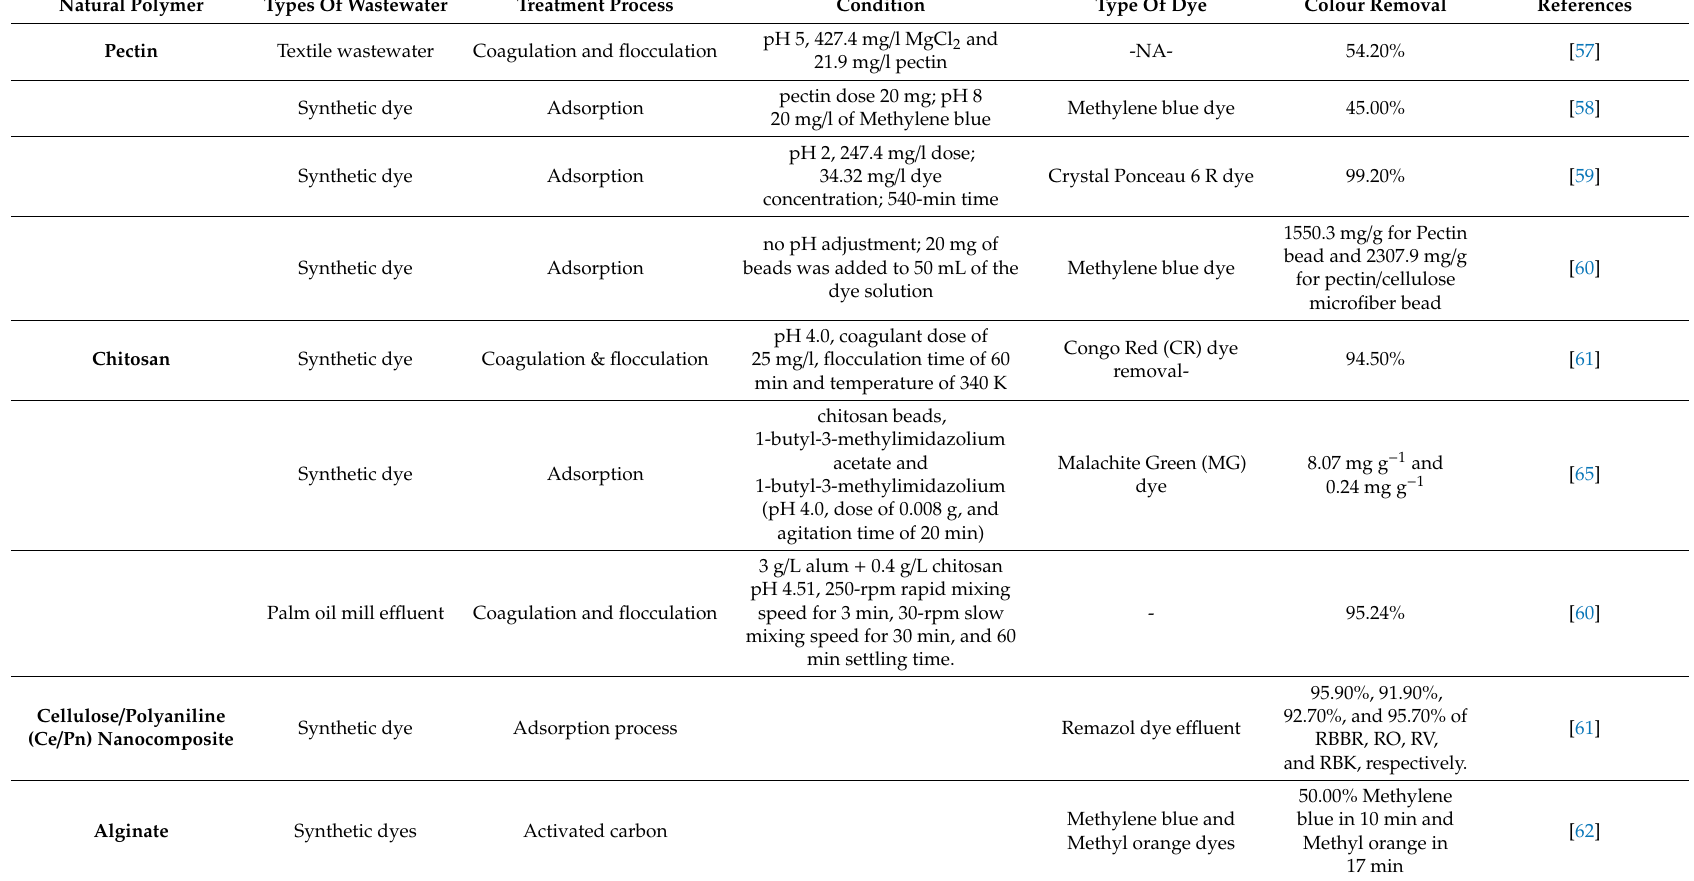
Table 5. Treatment of several types of wastewater using natural